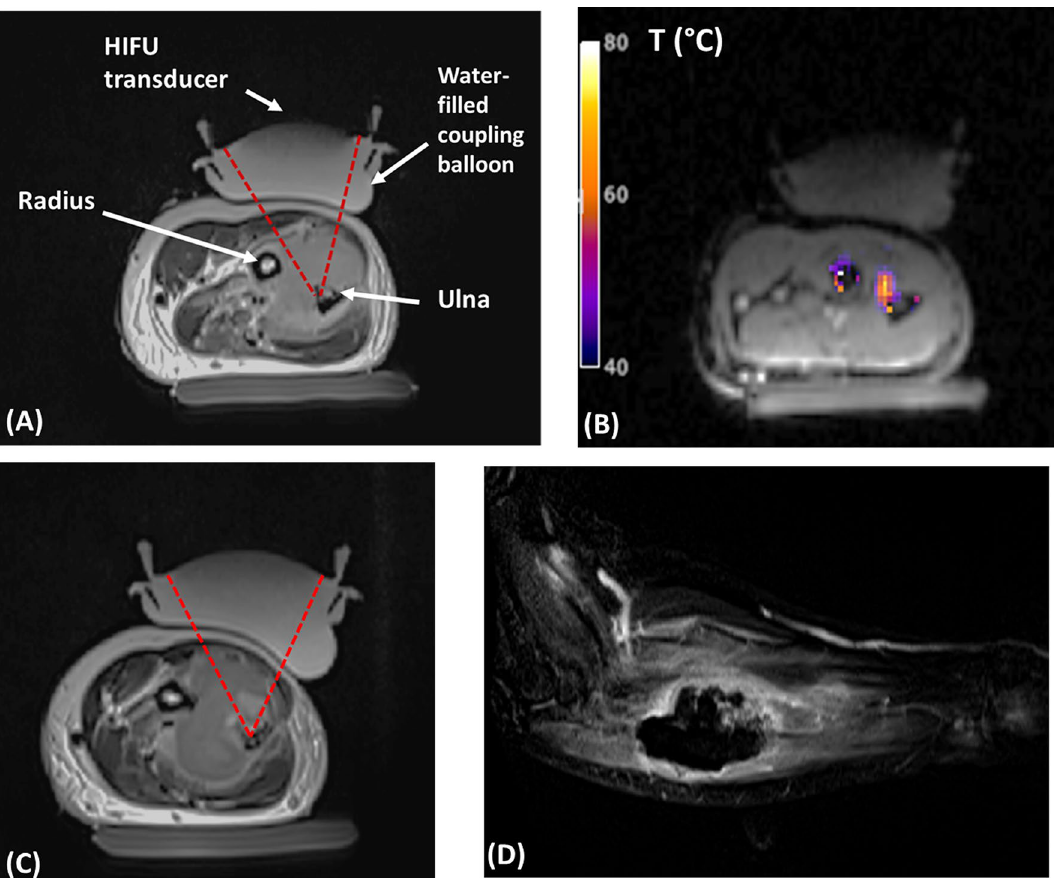
Figure 7. ( A ) Pre-operative T2w anatomical image of the forearm before the first HIFU ablation, illustrating the experimental setup, and showing the metastasis of the ulna. ( B ) Temperature map measured by MR thermometry, showing the temperature elevation in the upper part of the ulna, as planned. ( C ) Intermediate anatomical image after transducer repositioning, at a different MR slice. ( D ) Post-operative Gd-enhanced T1w image, showing in hyposignal the large volume that has undergone necrosis after HIFU